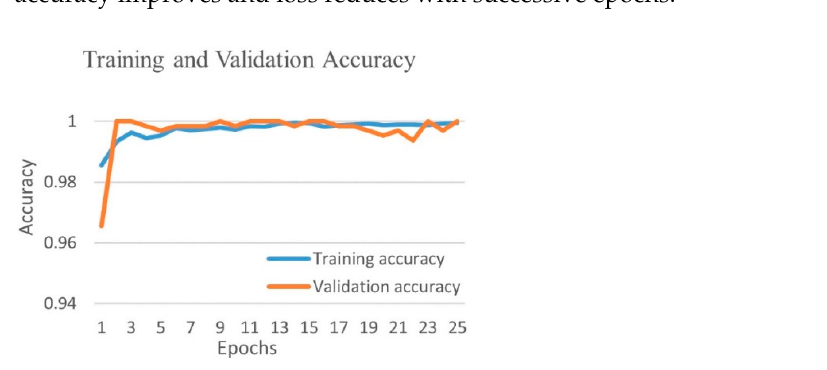
Figure 10. Training and validation accuracy of best performing DenseNet201 model for COVID-19 and bacterial pneumonia class.